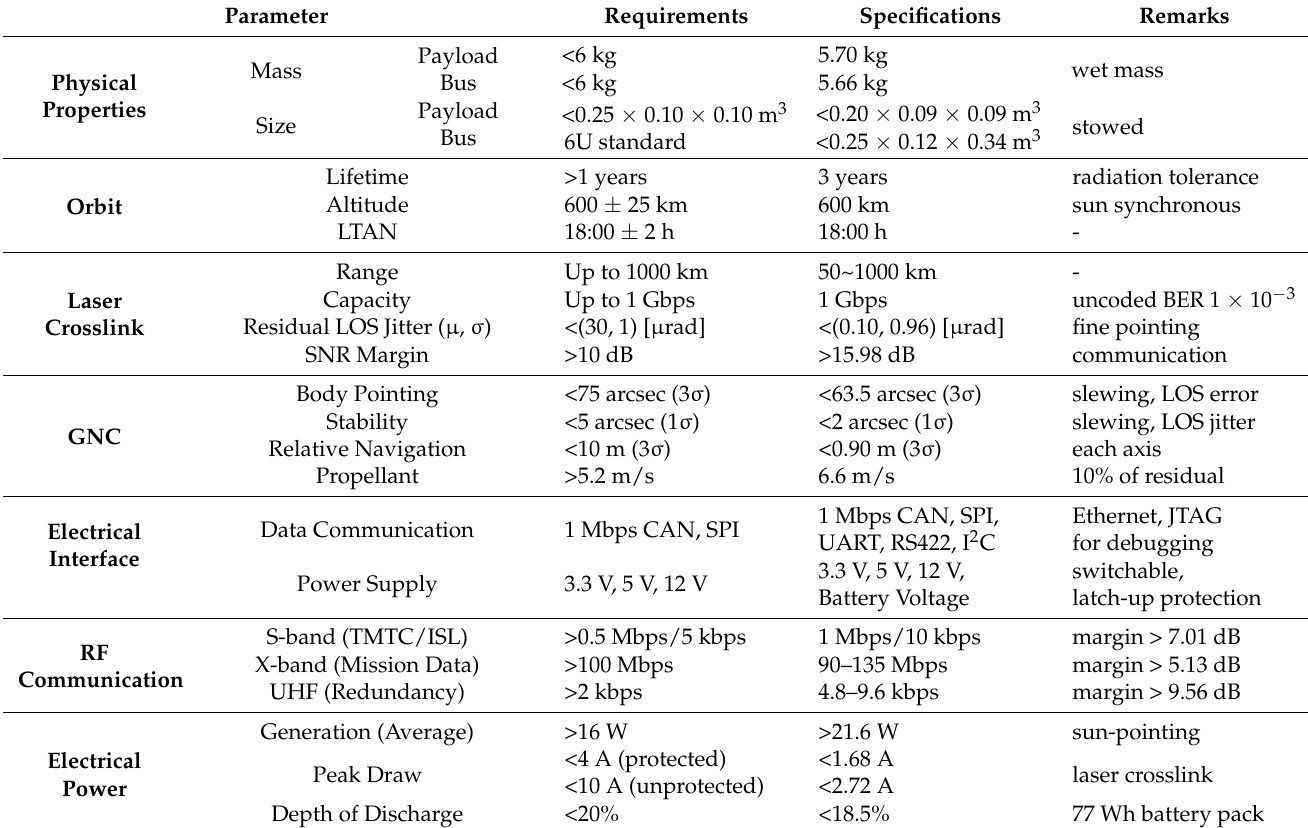
Table 5. Systems requirements and design